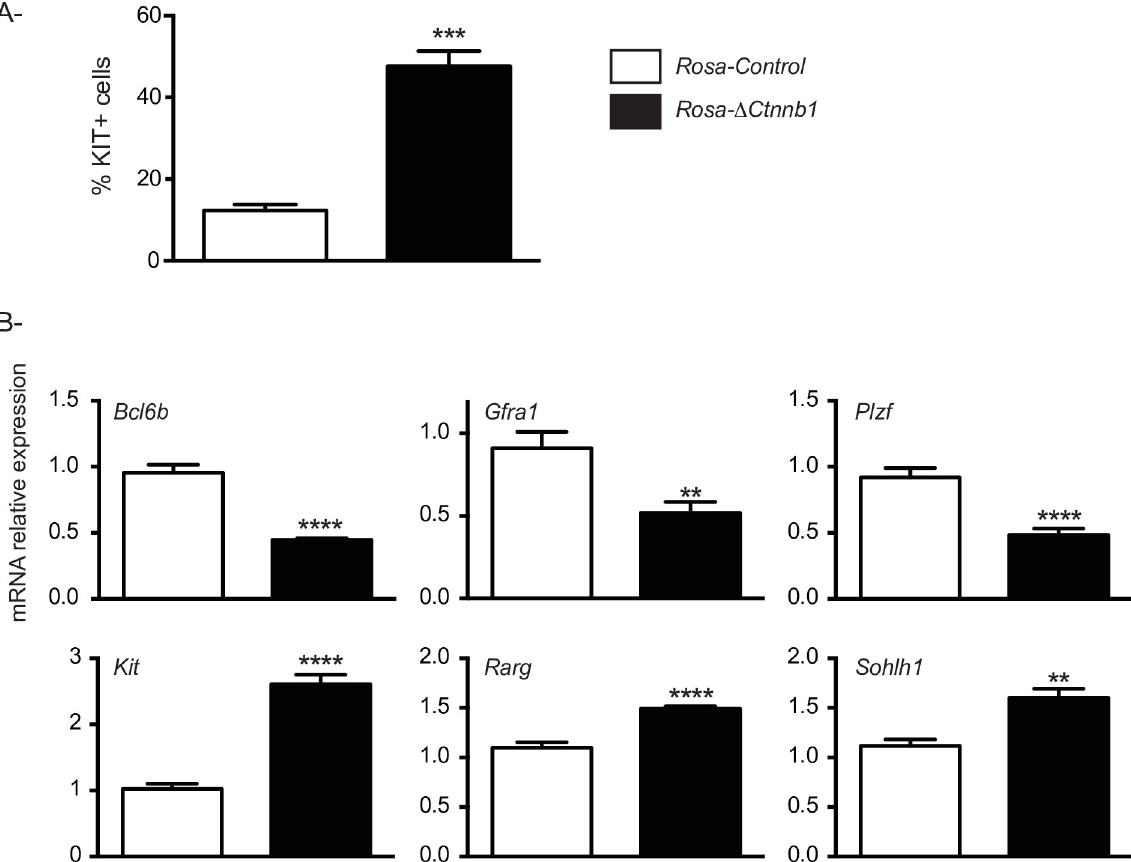
Fig 5. CTNNB1 stabilization skews cluster cell fate towards differentiation. A) Evaluation of the number of KIT+ cells in Thy1-positive cell clusters derived from Rosa - Δ Ctnnb1 mice and Rosa- control mice (n = 3). B) RT-qPCR analysis of the expression of genes involved in SSC maintenance or their transition to undifferentiated progenitor spermatogonia in clusters derived from Rosa - Δ Ctnnb1 and Rosa- control mice (n = 10 for Rosa- control and n = 11 Rosa - Δ Ctnnb1 for Gfra1 , Plzf and Kit and n = 6 /genotype for Bcl6b , Rarg and Sohlh ). RT-qPCR data were normalized to the housekeeping gene Rpl19 . All data are expressed as mean (columns) ± SEM (error bars). Asterisks indicate significant differences from controls ( �� P < 0.01; ��� P < 0.001; ���� P < 0.0001).